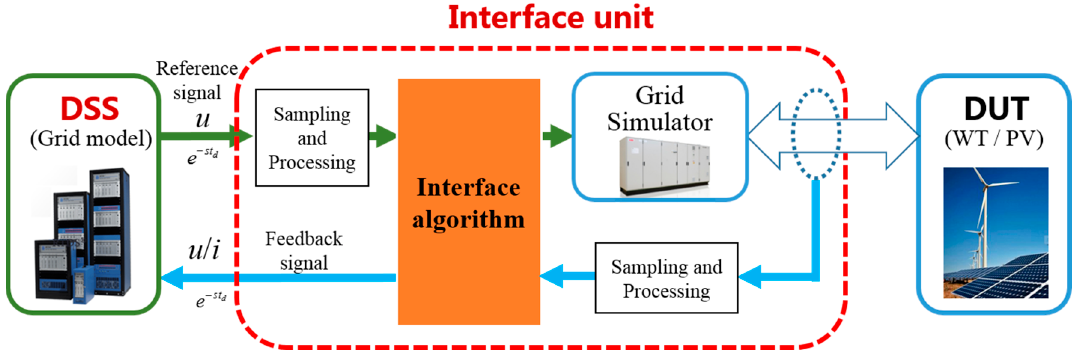
Figure 1. Block diagram of a real-time integration simulation system.